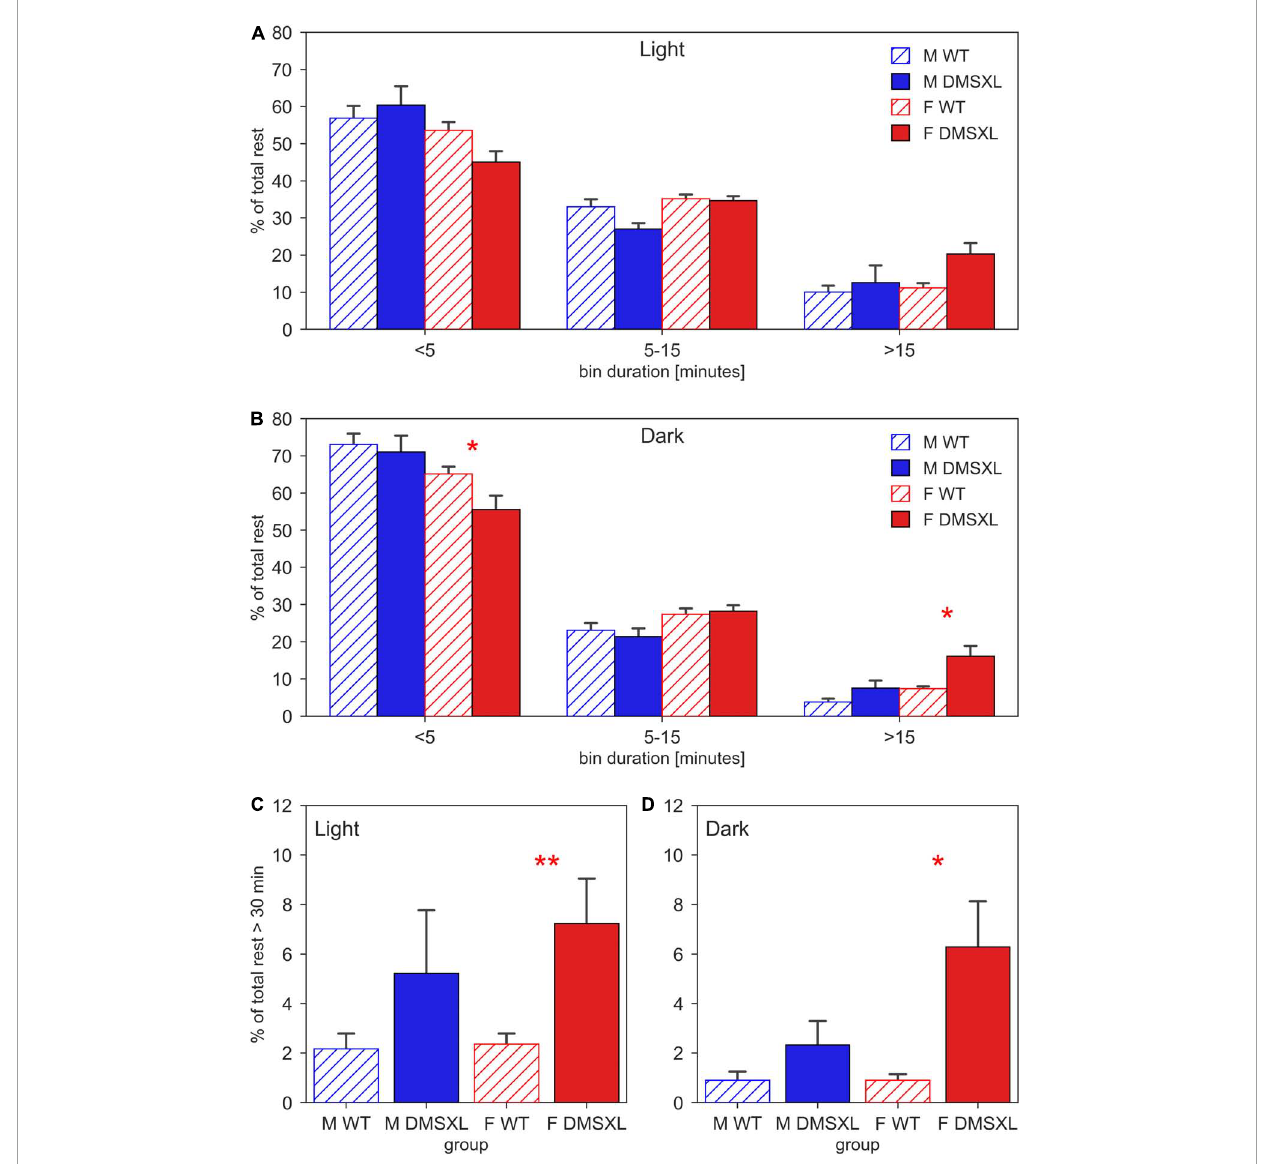
FIGURE5 Duration of resting bouts. Time-weighted frequency histogram of the durations of rest bouts during light (A) and dark phases (B) , across the 5 weeks of experiment in male (M, blue) and female (F, red) cages of wild-type (WT) (diagonal lines) and DMSXL (filled bar) mice. N of cages per group: M WT = 10; M DMSXL = 10; F WT = 11; F DMSXL = 8. The rest bouts (sequences of consecutive 0-activity of a minimum length of 40 s) are divided in three bins of different durations: < 5 min, 5–15, > 15 min. The bottom panels focus on the rest bouts longer than 30 min during light (C) and dark (D) phases. In (B–D) , Bonferroni-corrected post-hoc tests were performed to compare DMSXL and WT males (blue asterisks), and DMSXL and WT females (red asterisks) per each bin duration, (* p < 0.05, ** p < 0.01 two sample Wilcoxon